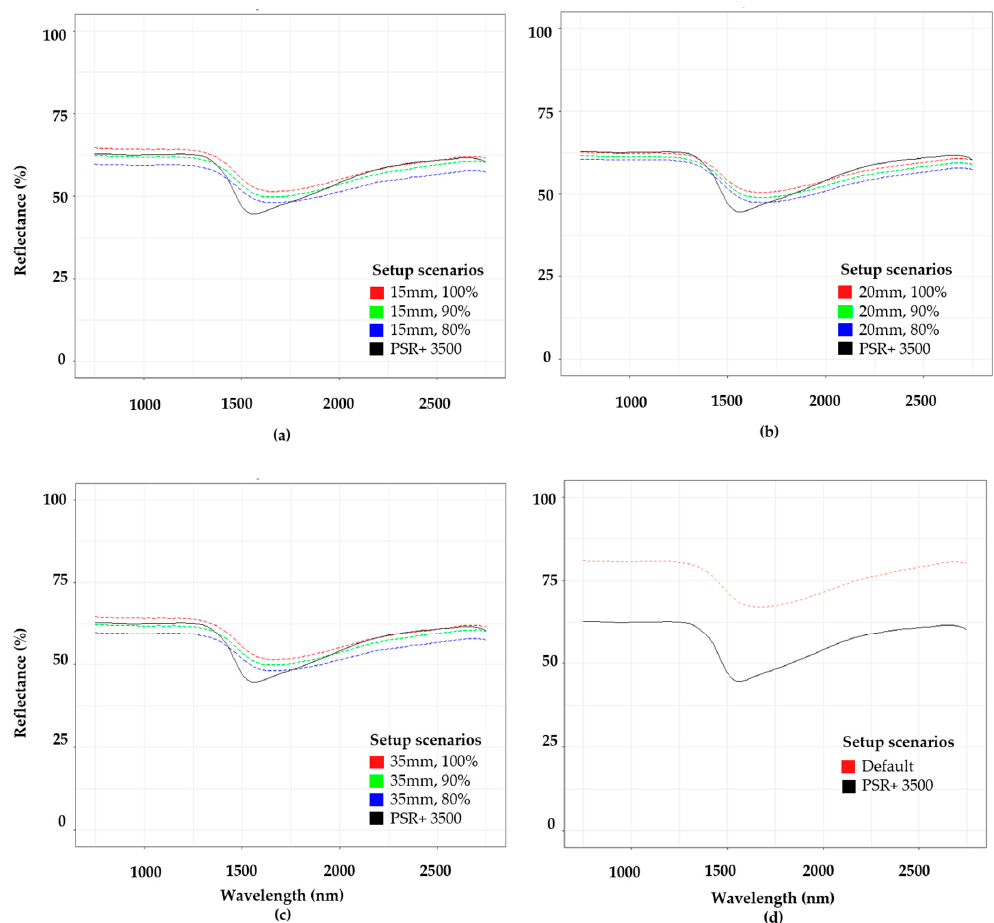
Figure 5. Median reflectance of subset dataset soil samples over ten different scenarios. A black solid line in each figure denotes the PSR+ 3500 median reflectance values. ( a ) Reflectance percentage for 15 mm height and three different light intensities. ( b ) Reflectance values with 20 mm distance from soil sample to MEMS sensor device and the three tested light intensities. ( c ) Reflectance values for 35 mm height from soil sample and the three tested light intensities. ( d ) Default setup (proximal sensed samples with 100% light intensity).